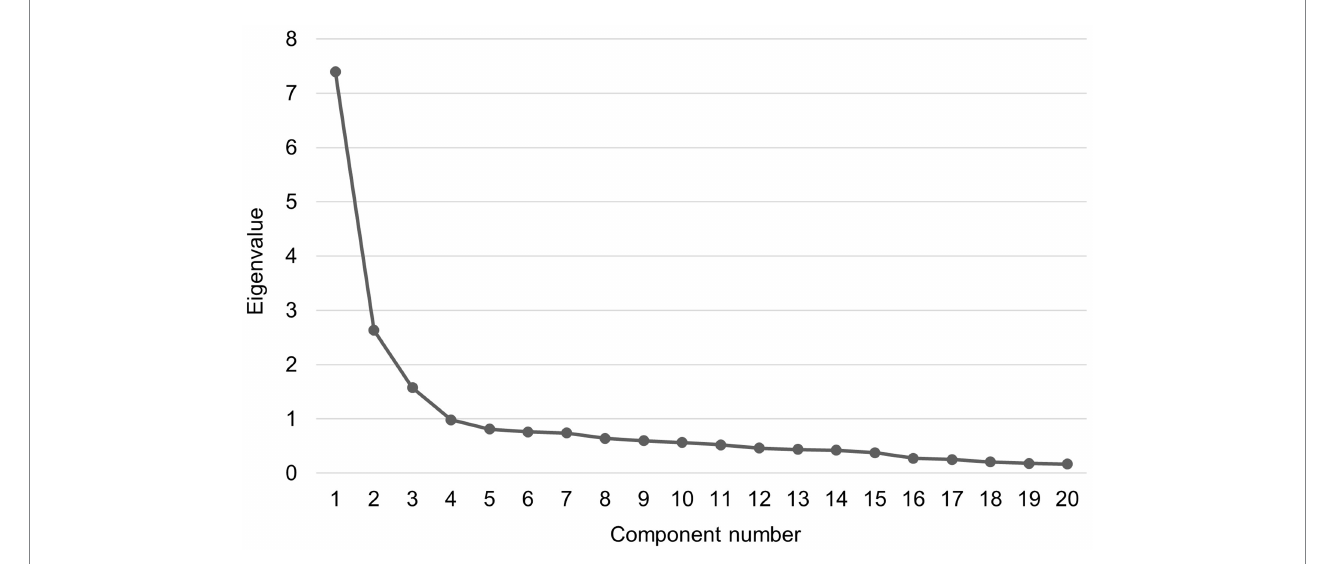
FIGURE 1 Scree plot of exploratory factor analysis for the 20-item Finnish version of Yale Food Addiction